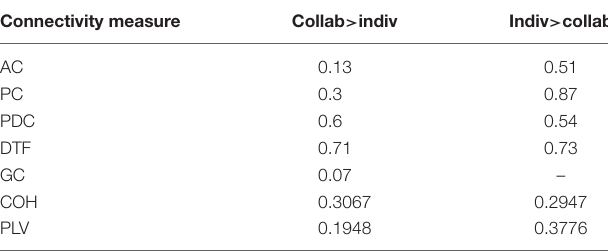
TABLE 2 | Contrasting the collaborative and individual conditions using different coupling methods. Connectivity